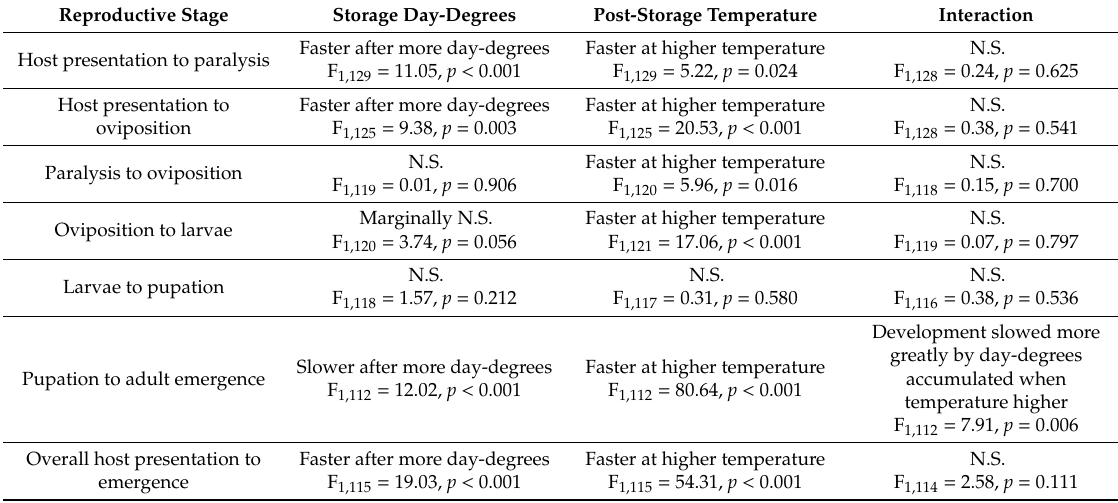
Figure 5. The e ff ects of pre- and post-storage temperatures on the duration of Sclerodermus brevicornis reproduction. The fitted curve was estimated using ANCOVA assuming gamma errors and a reciprocal link (for 23 ◦ C, time = 1 / ((0.00000919 × Day-degrees) + 0.025349); for 28.5 ◦ C, time = 1 / ((0.00000919 × Day-degrees) + 0.033639)). Table 4. E ff ects of pre- and post-storage temperatures on the timing of Sclerodermus brevicornis reproduction. Data were analyzed using analysis of covariance (ANCOVA) assuming gamma errors and a reciprocal link-function. N.S. = non-significant e ff